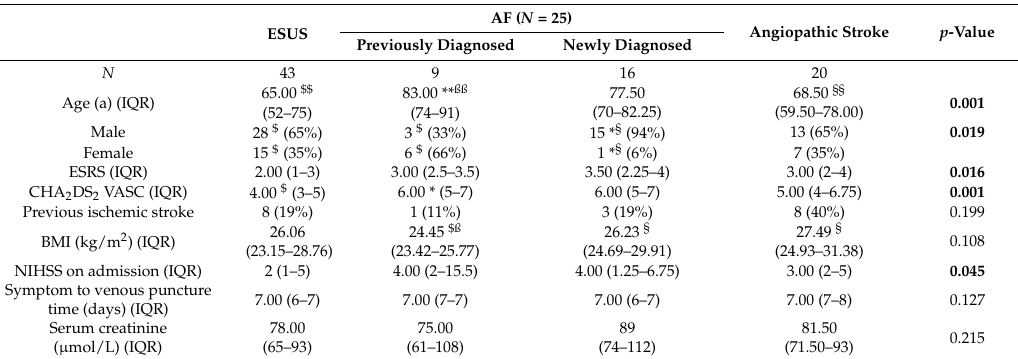
Table 1. Baseline characteristics.